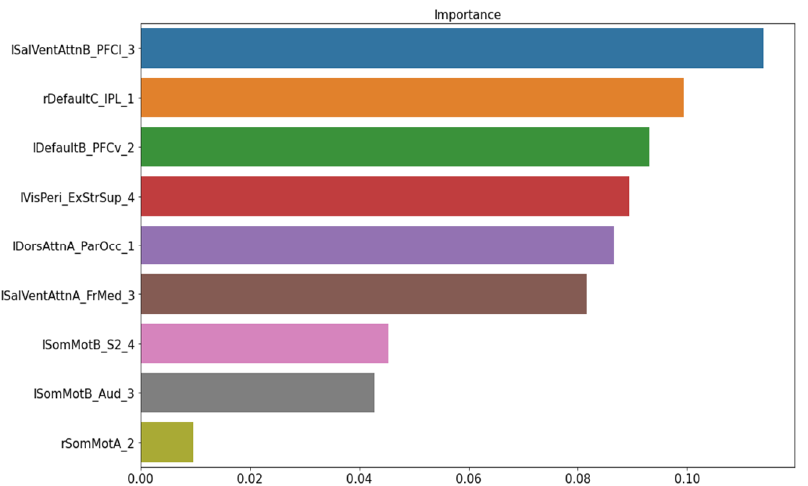
Figure 3. The important feature ranking in the baseline model of structural data. Note: lSalVen- tAttnB_PFCI_3 = the lateral prefrontal cortex regions of the left salience ventral attention network B; rDefaultC_IPL_1 = the right inferior parietal lobule node 1 of the default mode network C; lDe- faultB_PFCv_2 = the ventral prefrontal cortex node 2 of the left default mode network; MisPeri_Ex- StrSup_4 = extra-striate superior node 4 ; lDorsAttnA_ParOcc_1 = parietal occipital node 1 of the left dorsal attention network A; lSalVentAttnA_FrMed_3 = the medial frontal node of the left salience ventral attention network A; lSomMotB_S2_4 = the S2 node 4 of the left sensorimotor network B; lSomMotB_Aud_3 = the auditory node 3 of sensorimotor network B ; rSomMotA_2 = the right sen- sorimotor network A node 2.